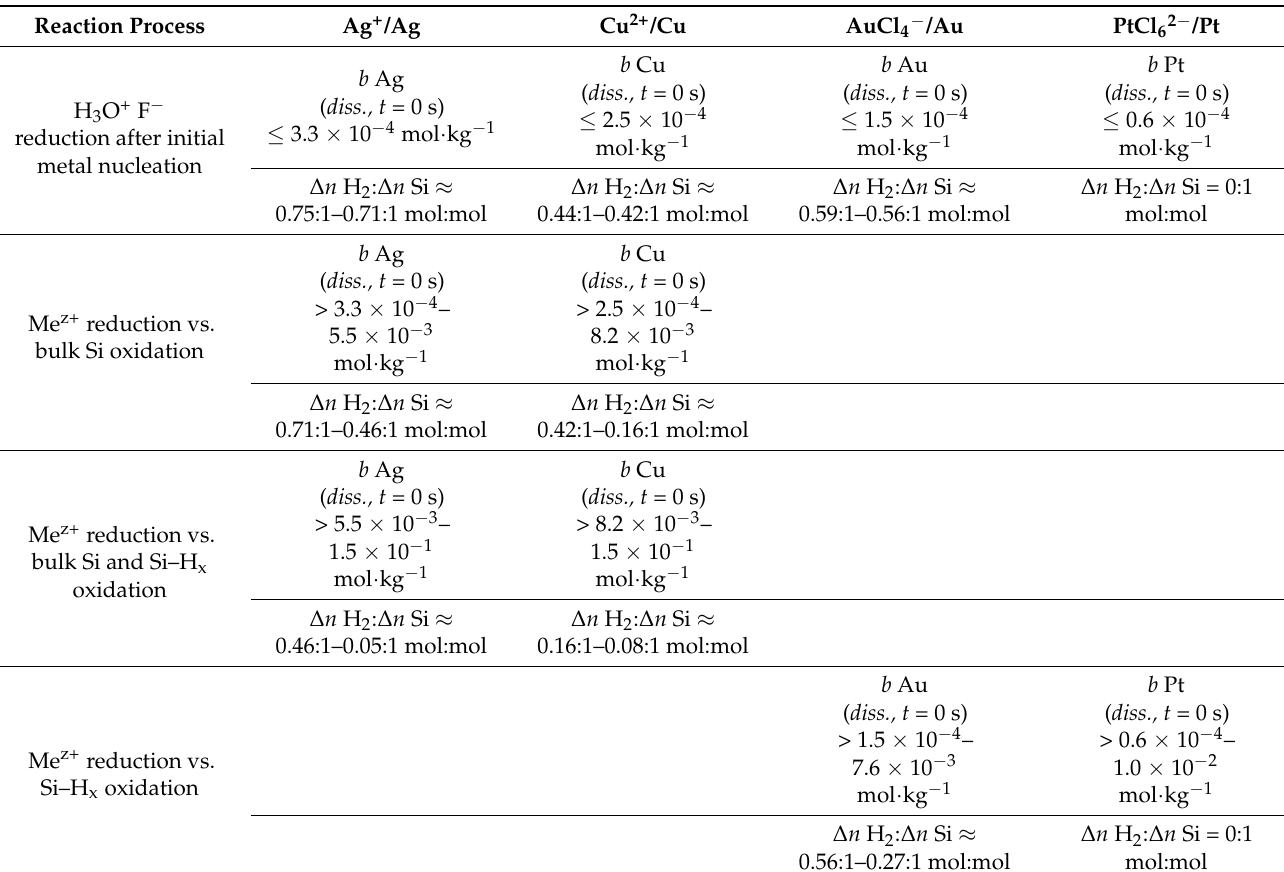
Table 1. Reaction processes and their range in relation to the initial metal ion molalities b Me (diss., t = 0 s) and the analytically derived average ∆ n H 2 : ∆ n Si